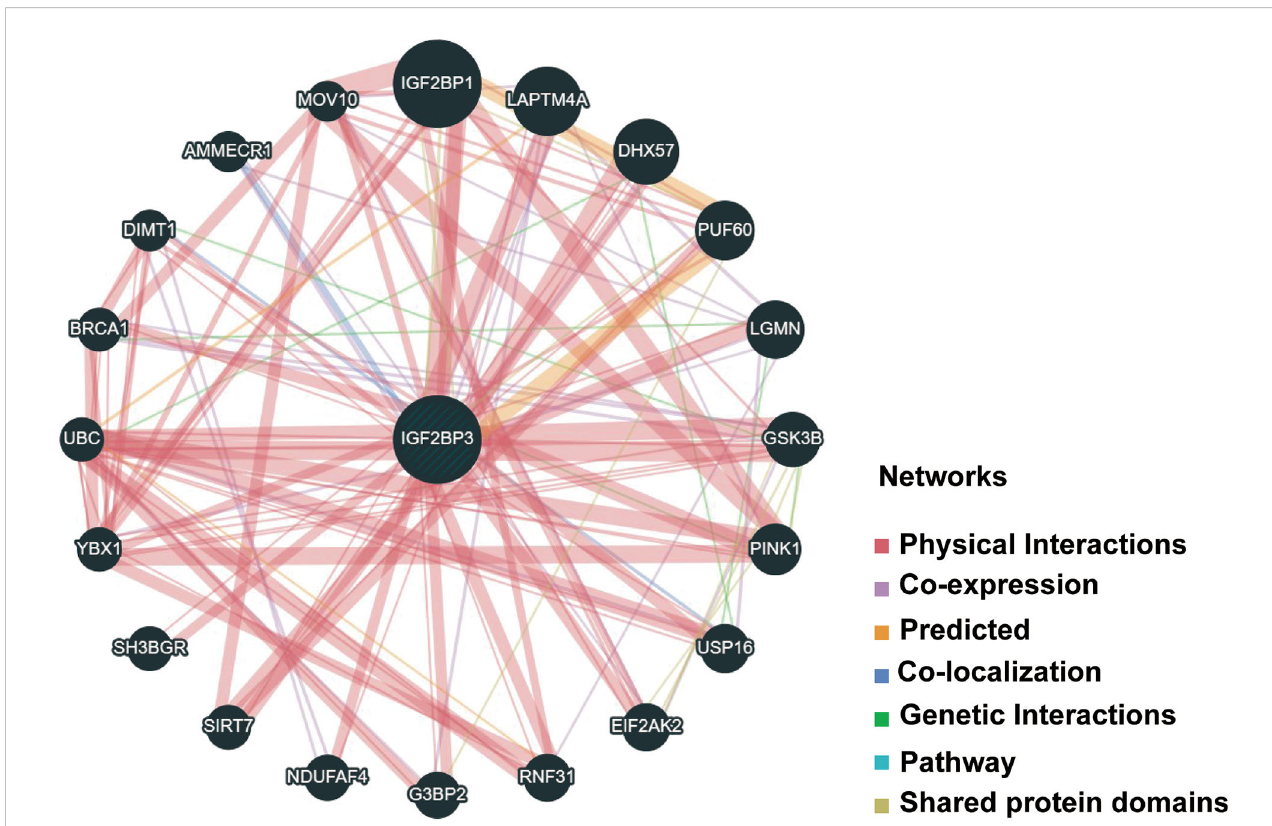
FIGURE 11 PPI network for IGF2BP3 was constructed via GeneMANIA. Different colors of the network edge indicate the bioinformatics methods applied: physical interaction, coexpression, predicted, colocalization, pathway, genetic interaction, and shared protein domains. PPI, protein – protein interaction.